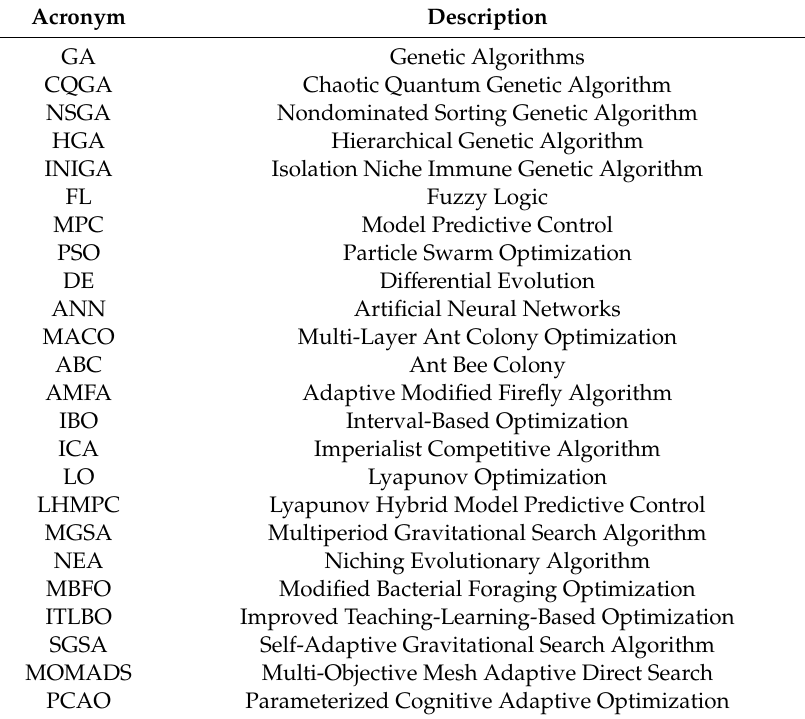
Table A2. Computational intelligence